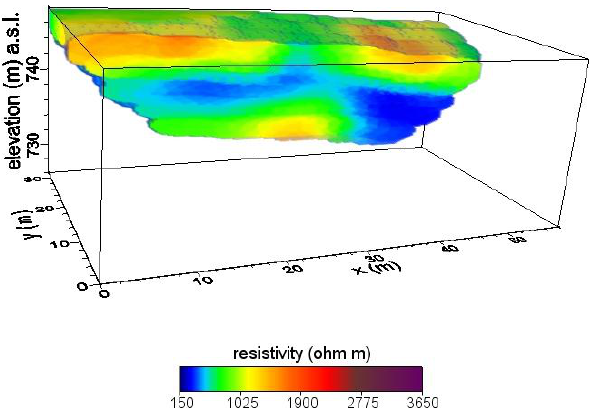
Fig. 5. Resistivities of the investigated buried volume obtained from the results derived from the 3-D data inversion for the autumn survey.